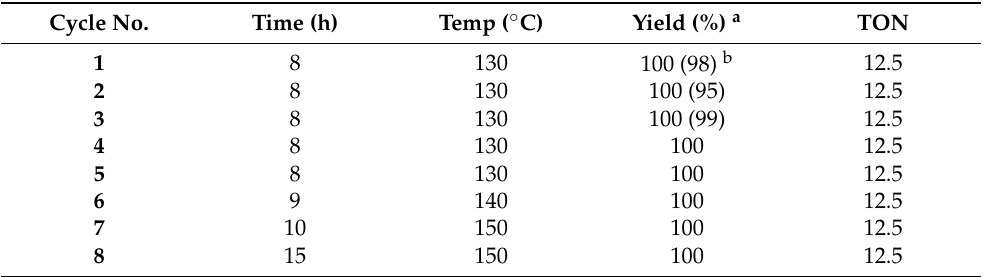
Table 4. Recycling results of 2a -catalyzed Stille reaction of 4-iodotoluene ( 7 ) and vinyl tributyltin ( 3 ) under thermomorphic